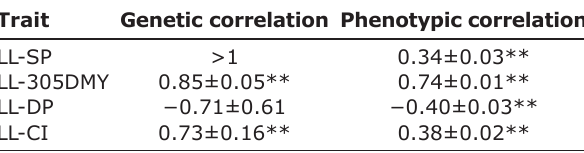
Table-3: Genetic and phenotypic correlation between LL and other traits in Sahiwal cattle.